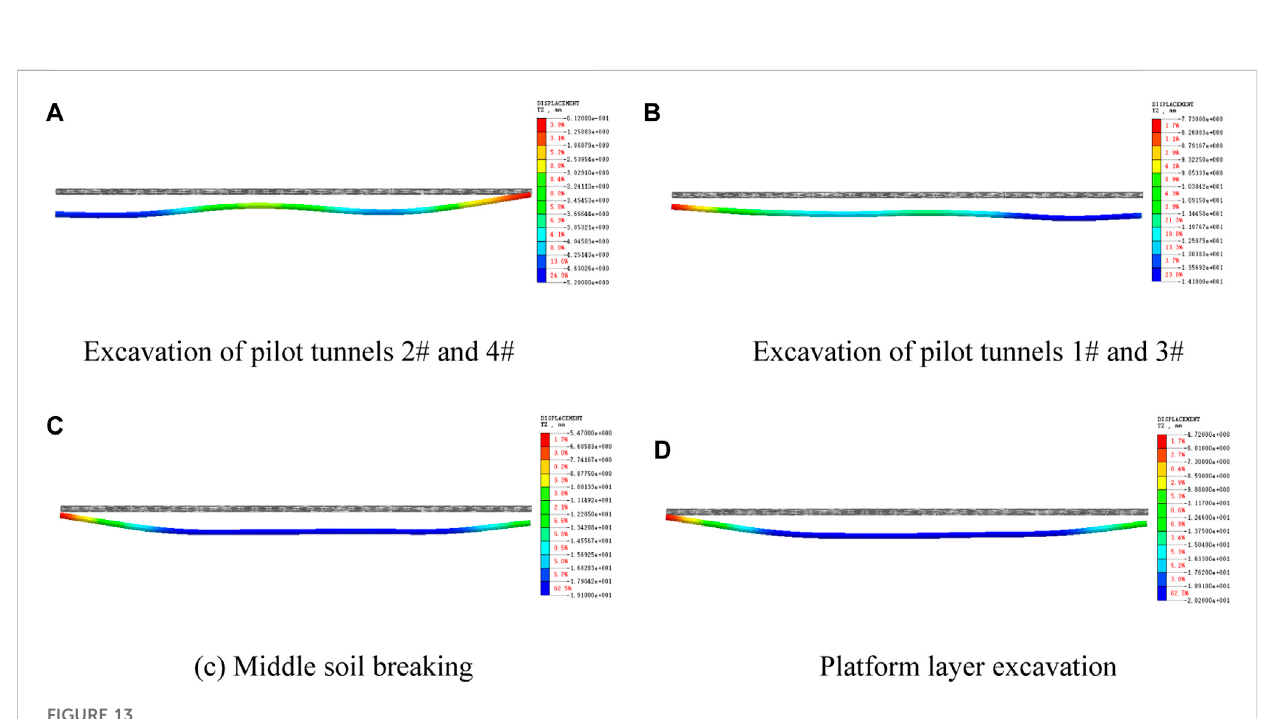
FIGURE 13 Steel tube deformation